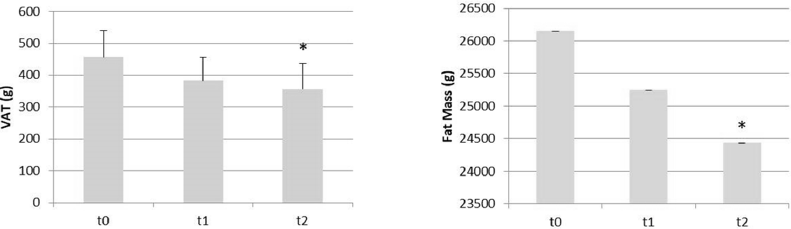
Table 3. Descriptive statistics for the hormonal pattern and acne status measured at baseline (t0) and after 60 days (t2) of BBR-PP supplementation. Table 4. Descriptive statistics for the body composition measured at baseline (t0) and after 60 days (t2) of BBR-PP supplementation.